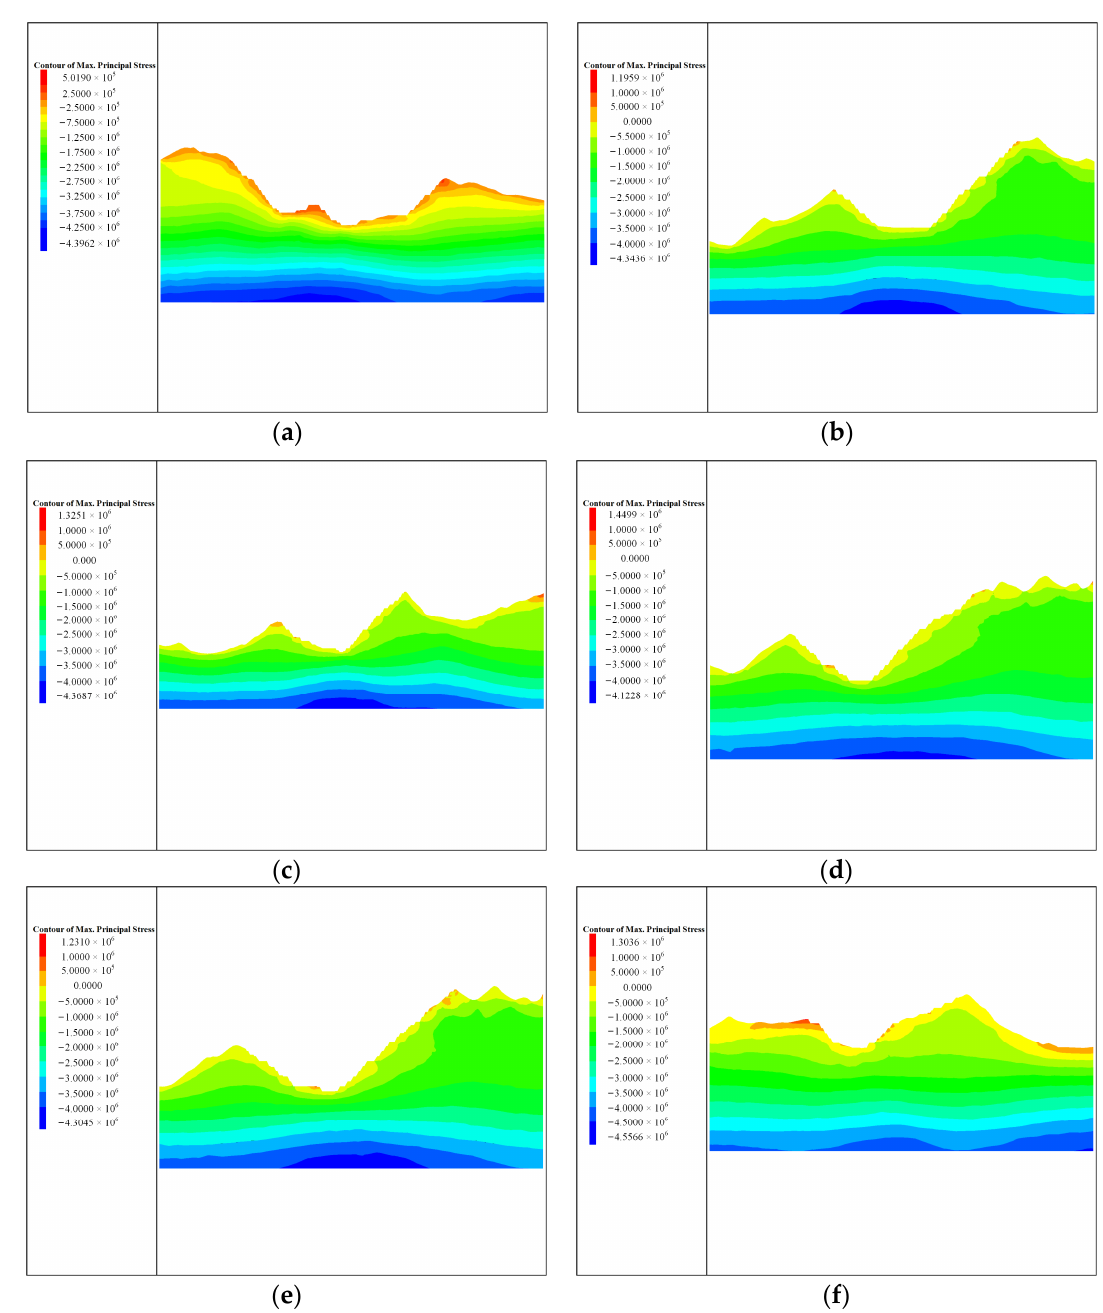
Figure 10. The contour of max. principal stress in sections: ( a ) section A; ( b ) section B; ( c ) section C; ( d ) section D; ( e ) section E; ( f ) section F.